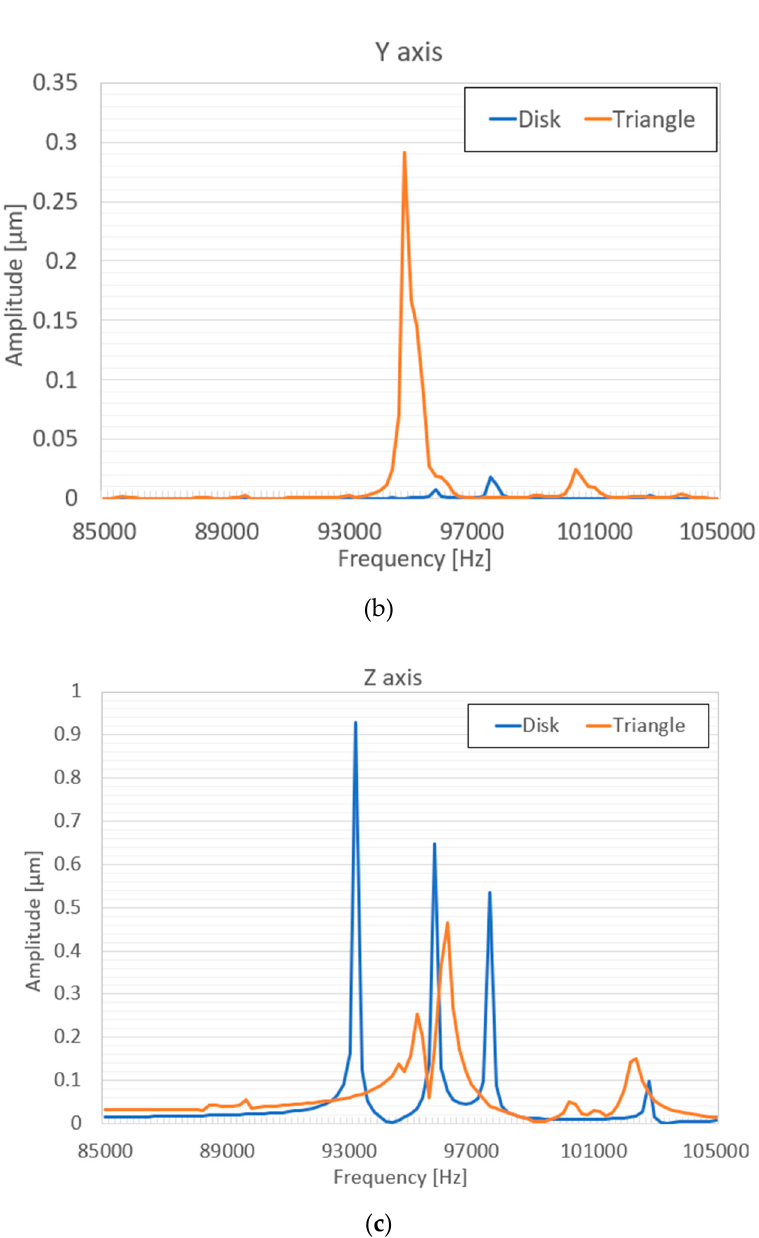
Figure 9. Comparison of the X, Y, and Z displacements versus frequency of actuators with the disc and triangle-shaped flanges: ( a ) displacements in x-direction; ( b ) displacements in y-direction ; ( c ) displacements in z-direction.